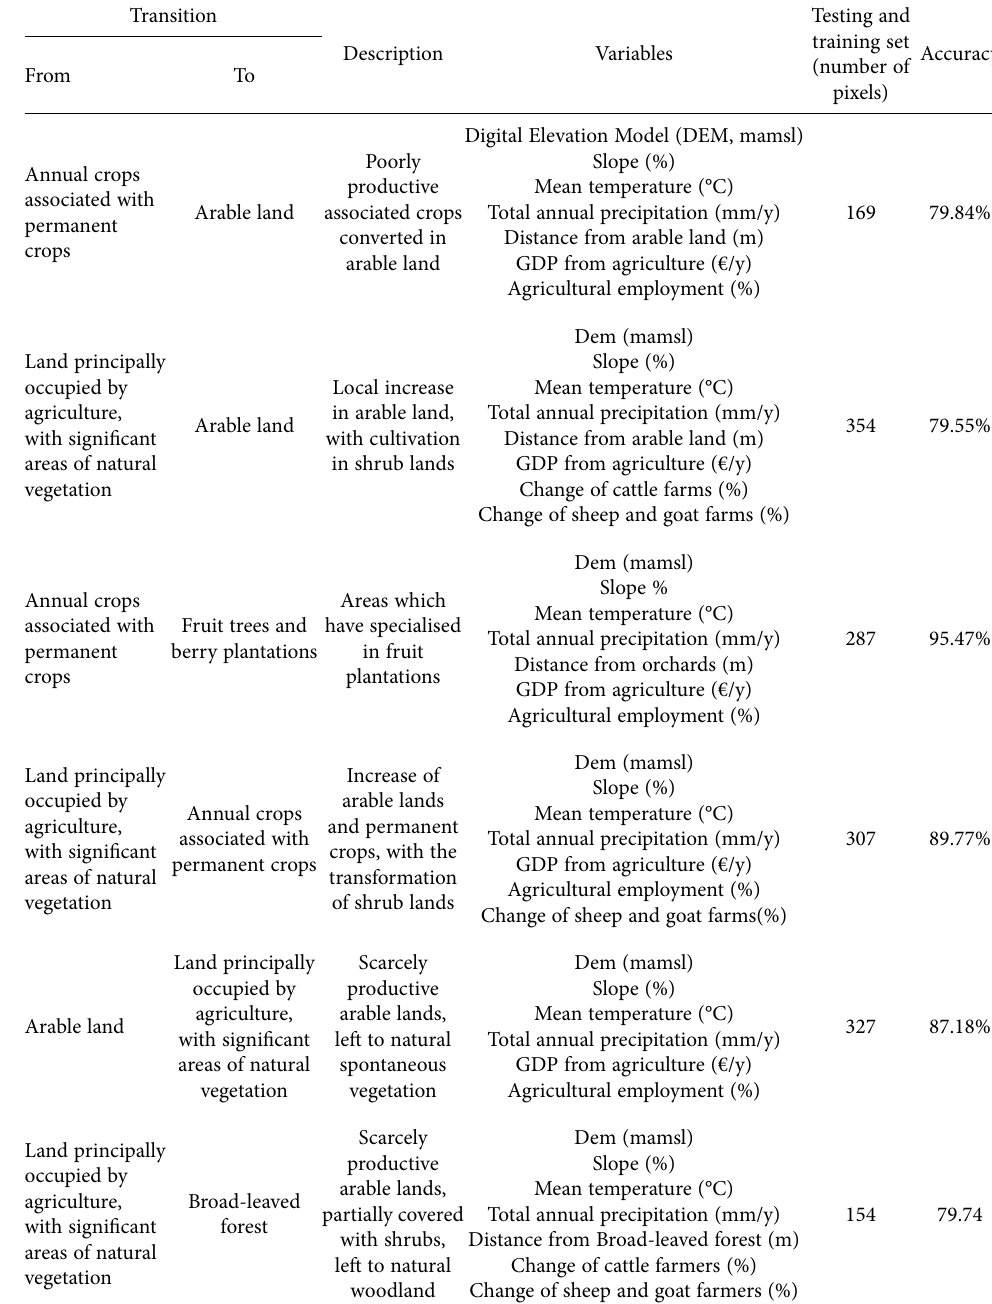
Table 3. Matrix of potential future transitions (baseline